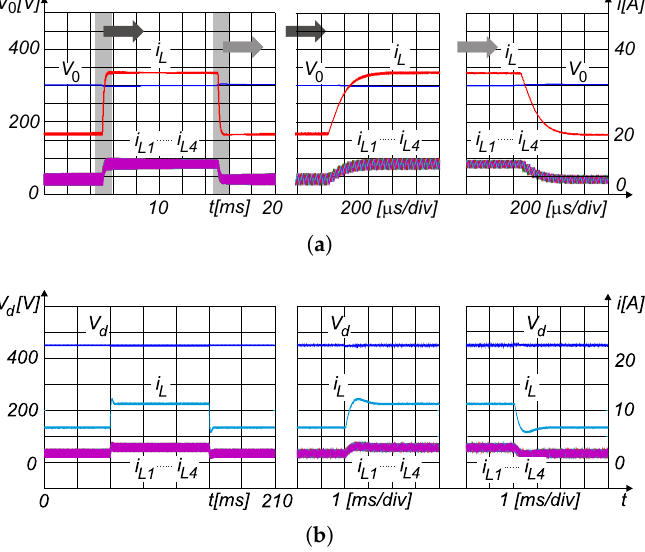
Figure 19. Simulation results, output voltage control at load transients (cut outs at load change); With current modulator, CR and PI voltage compensator; ( a ) buck mode ( V 0 (blue curve), i L (red curve), i L 1 (green curve), i L 2 (violet curve), i L 3 (cyan curve), and i L 4 (dark red curve)); ( b ) boost mode ( V d (blue curve), i d (light blue curve), i L 1 (green curve), i L 2 (violet curve), i L 3 (cyan curve), and i L 4 (dark red